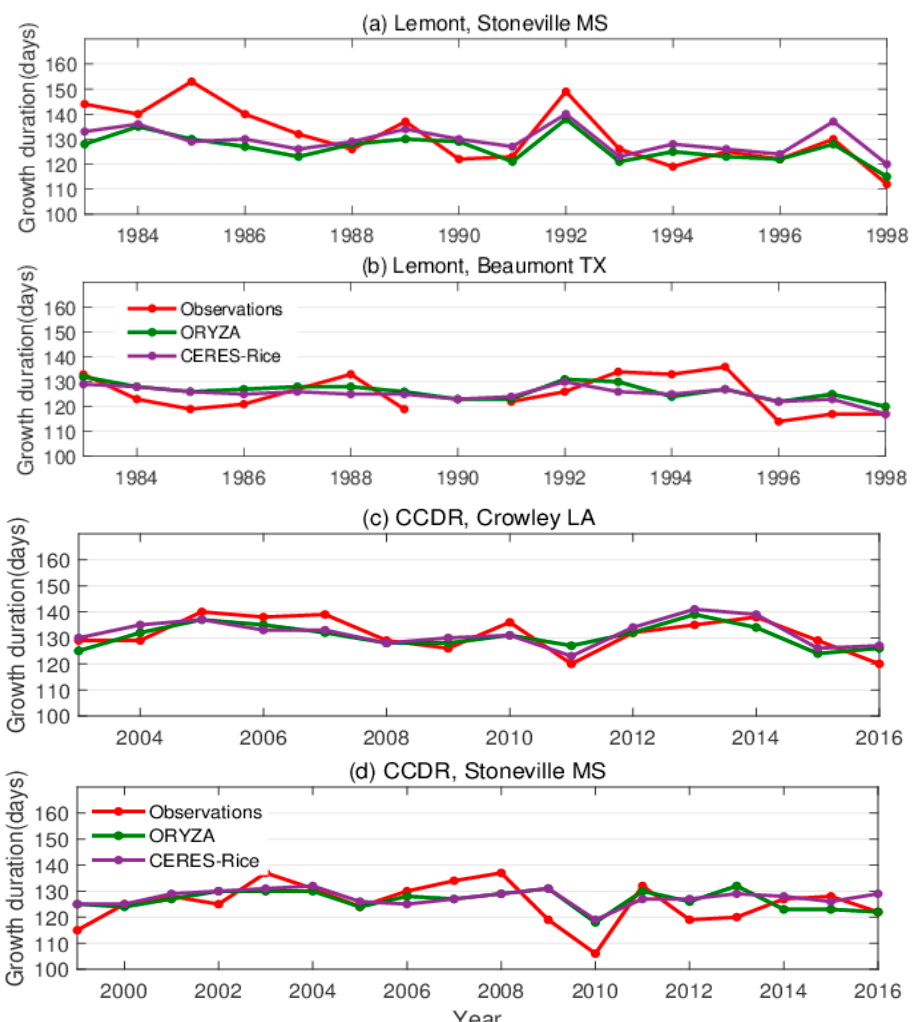
Figure 3. Comparison of observed and simulated rice growing season duration obtained from